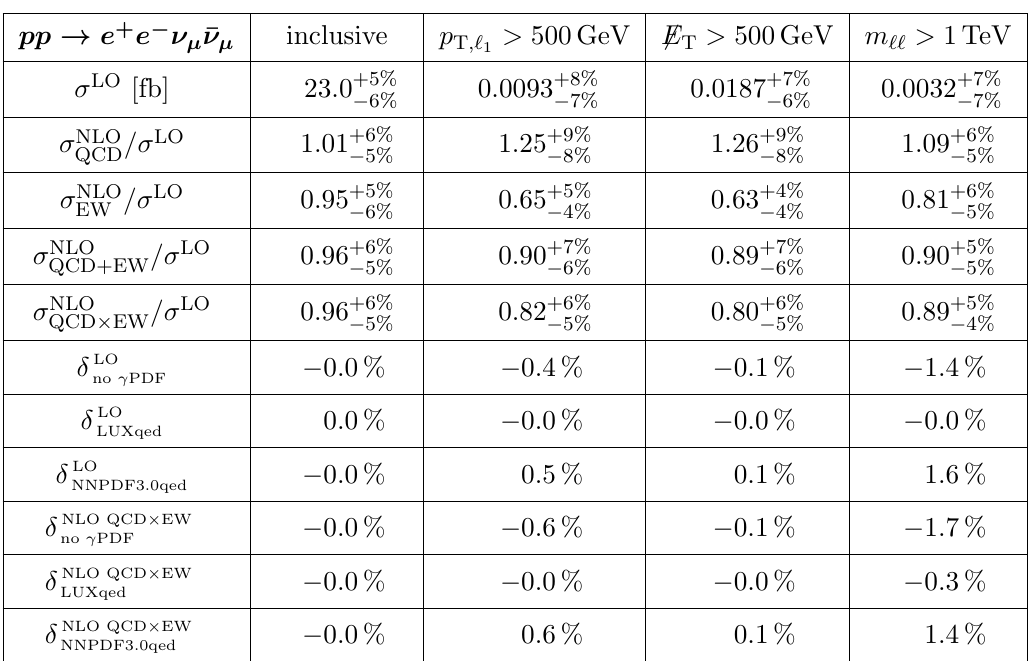
Table 8 . Cross-sections for pp e + e (cid:0) (cid:23) (cid:22) (cid:22) (cid:23) (cid:22) at 13 TeV. Higher-order corrections, scale uncertainties ! and photon-induced contributions are presented as in table